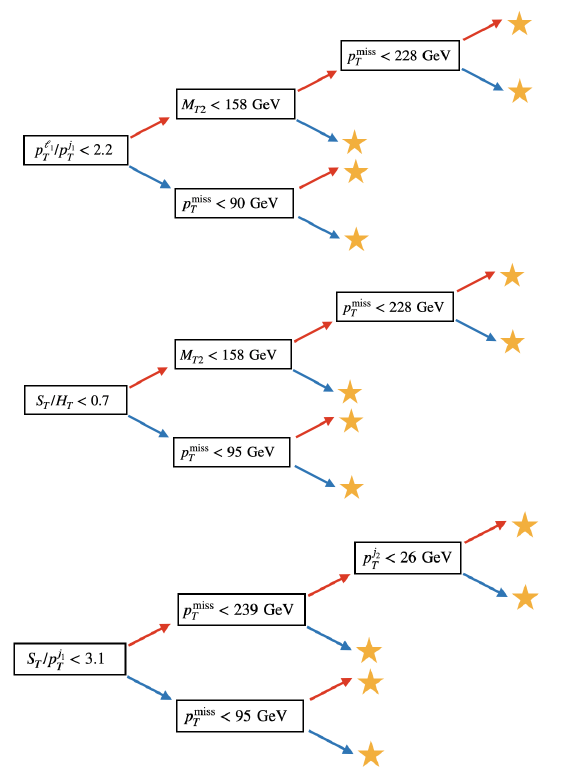
Figure 4 . The first, second, and tenth (top to bottom) trees built in the classifier trained on the benchmark ( m ˜ µ , m ˜ χ ) = (300 , 100) GeV . The red arrows indicate that the selection in the preceding box is satisfied, and the blue arrows indicate that either the event does not pass the selection or that the data is missing. Yellow stars indicate a leaf is reached. This model has a maximum depth of